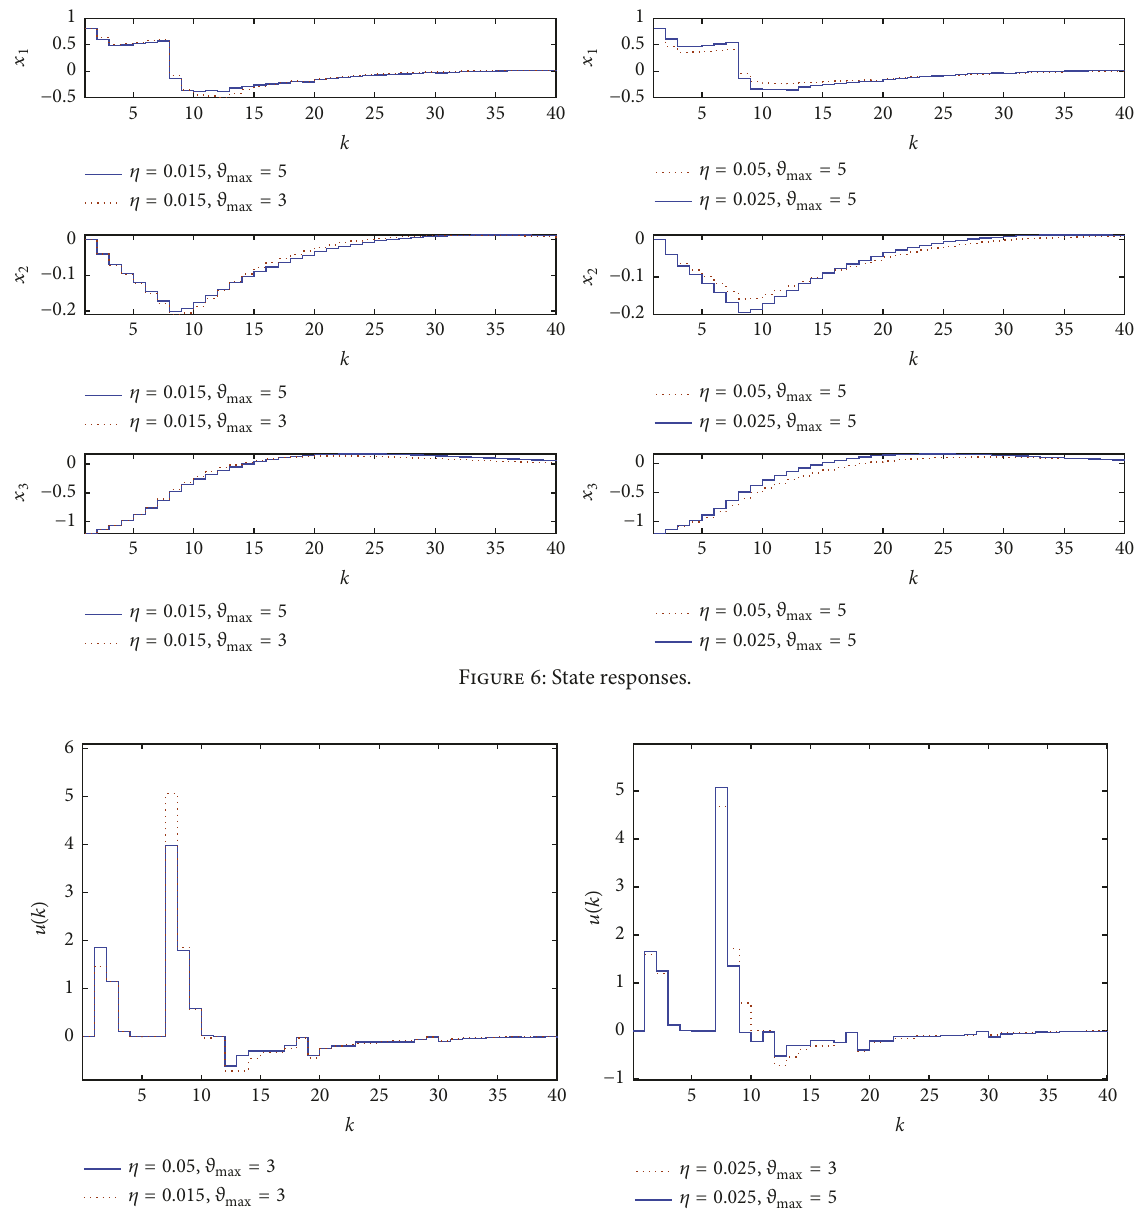
Figure 7: Control